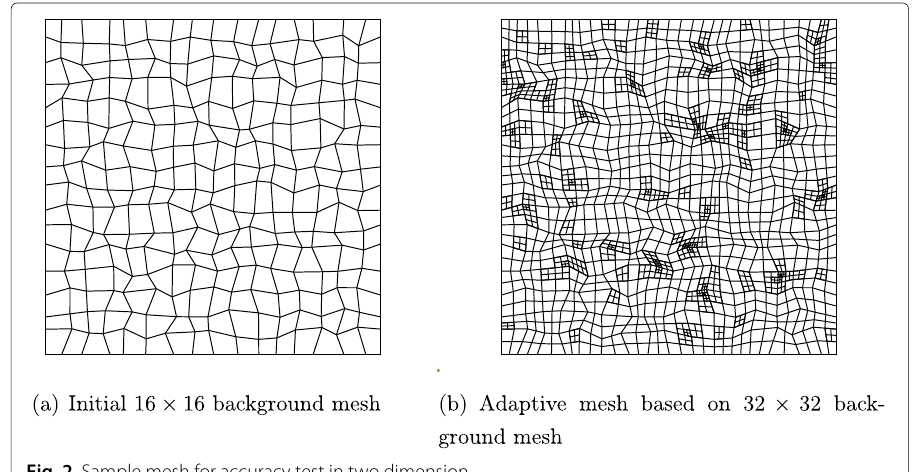
Fig. 2 Sample mesh for accuracy test in two dimension